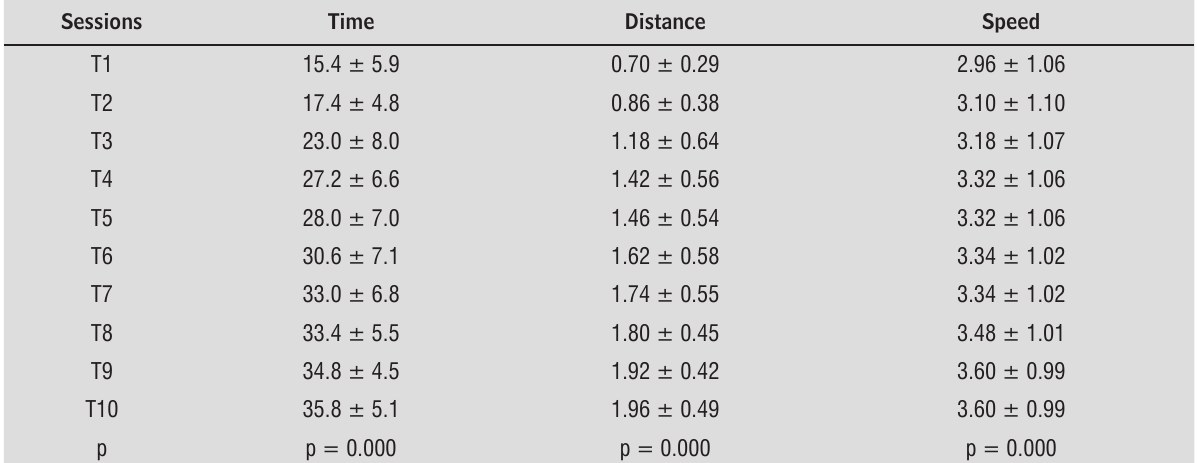
Table 1 - Mean ± Standard Deviation of time, distance and speed over the course of the 10-session physical therapy program